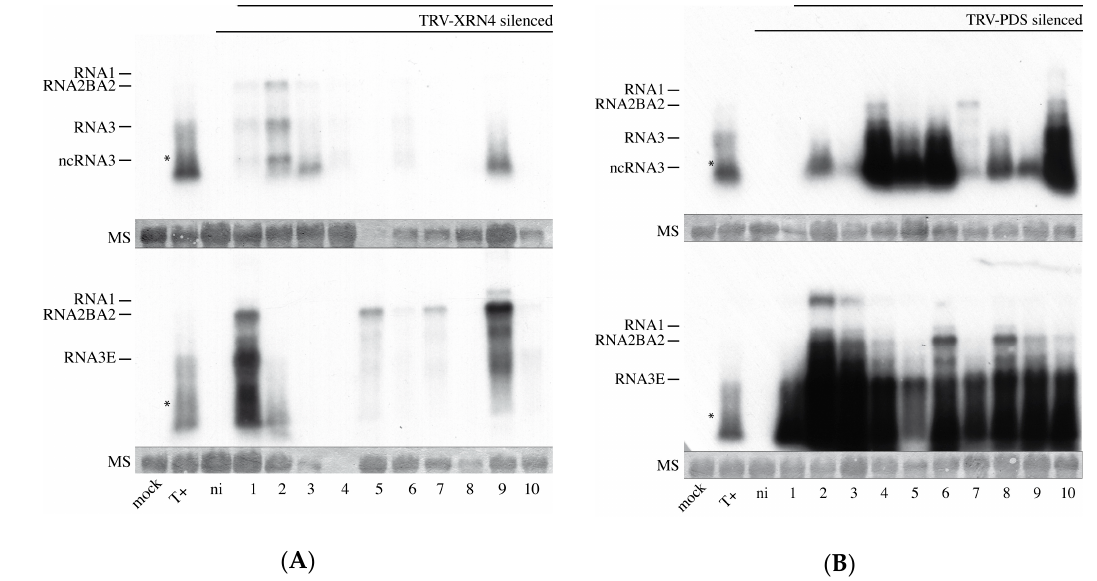
Figure 9. BNYVV RNA accumulation is compromised in XRN4 KD plants. TRV-XRN- ( A ) and TRV-PDS- ( B ) silenced N. benthamiana plants were rub-inoculated with RNA1+2BA2 supplemented with RNA3 (top) or RNA3E (bottom). Equivalent amount of total RNAs (~10 µg, visualized by methylene blue staining, MS) were extracted from the inoculated leaf of each plant (1–10) and analysed by northern blot using specific probes for BNYVV RNA1, 2, and 3. Mock, control plant; T+, N. benthamiana infected with RNA1+2BA2+RNA3; ni, TRV-silenced and non-inoculated with BNYVV. The poor quality of the northern blots is due to mixed TRV and BNYVV infection. Samples in panel A lanes 5 (top) and 4 (bottom) were lost. The asterisk indicates the position of ncRNA3. Upper bands of panel B (e.g., lanes 2 and 3) are of unknown origin and may correspond to uncompleted denaturation of viral RNAs. Panel A and B membrane treatments were simultaneous using the same combination and amount of probes. Both blots were exposed 120 h to allow the visualization of viral RNAs of panel A.